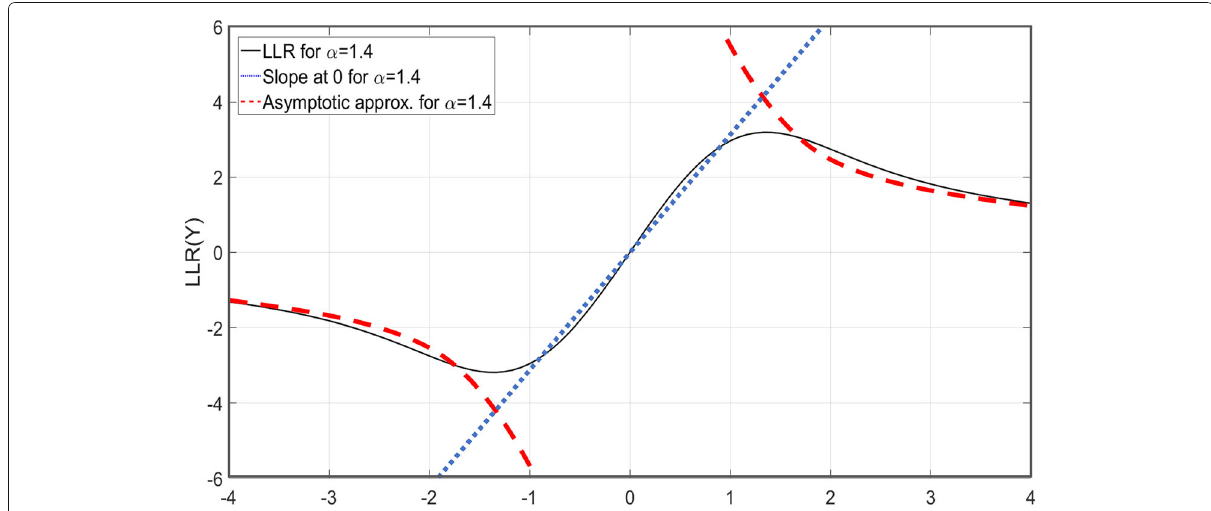
Fig. 2 LLR demapper approximations. The following parameters were used in our case: α = 1.4 and γ = 0.5